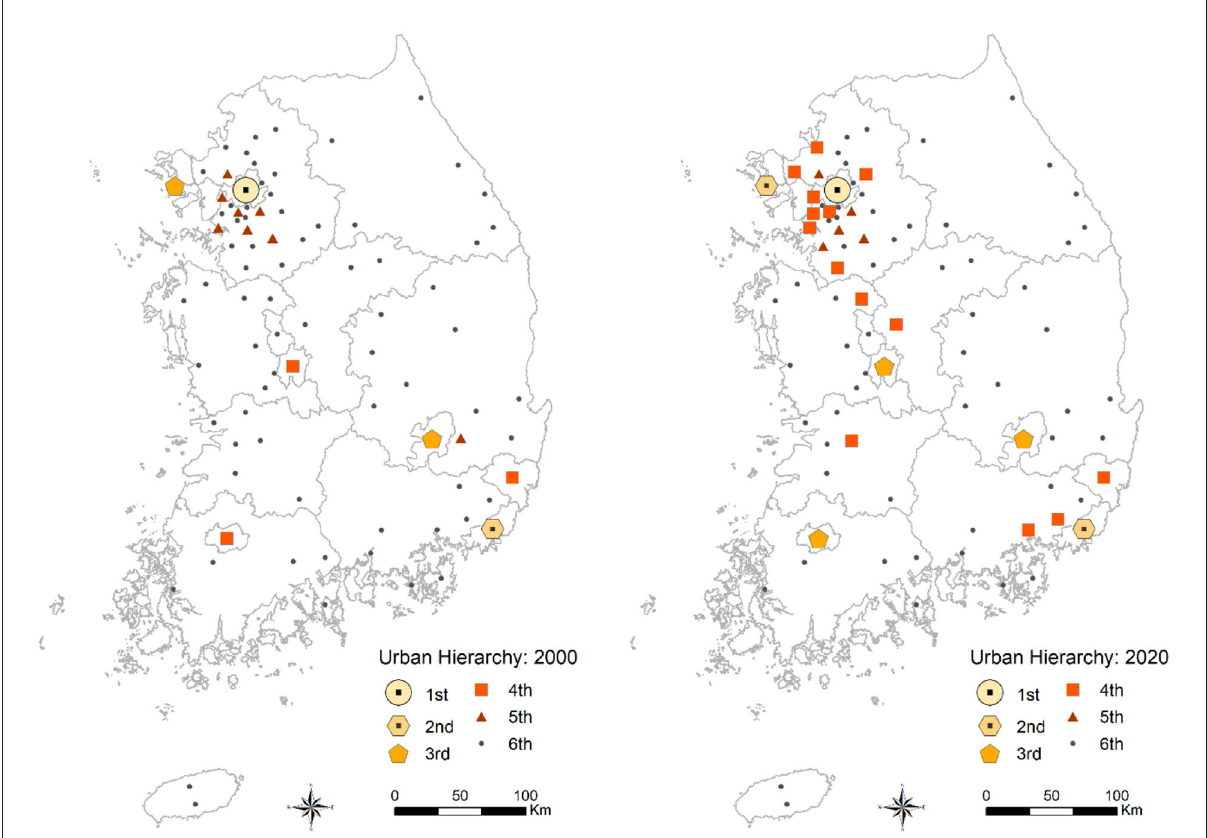
FIGURE7 Hierarchy of Korean cities (2000 and